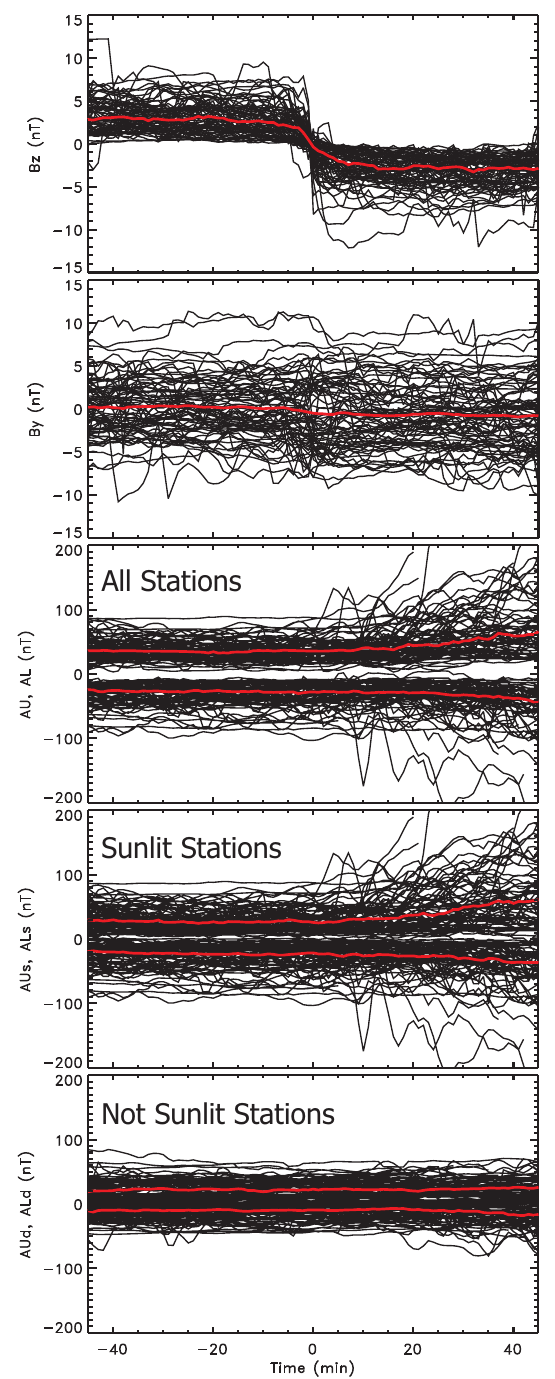
Figure 3 Fig. 3. Superposed epoch analysis for all 73 events (black lines) and median (red line) with the time of the southward turning defined as T =0. Top panel show the IMF B z ; second panel show the IMF B y ; third panel show AL/AU deduced from all stations; fourth and fifth panels show the AUs/ALs and AUd/ALd,